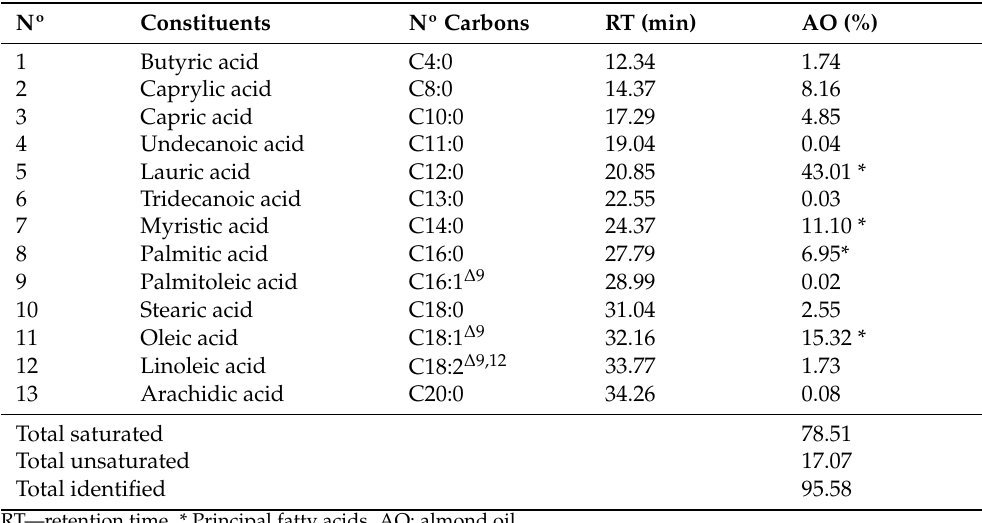
Table 2. Fatty acids identified in the fixed oil of the almond of A. heterophyllus after obtaining the corresponding methyl esters using GC-FID.